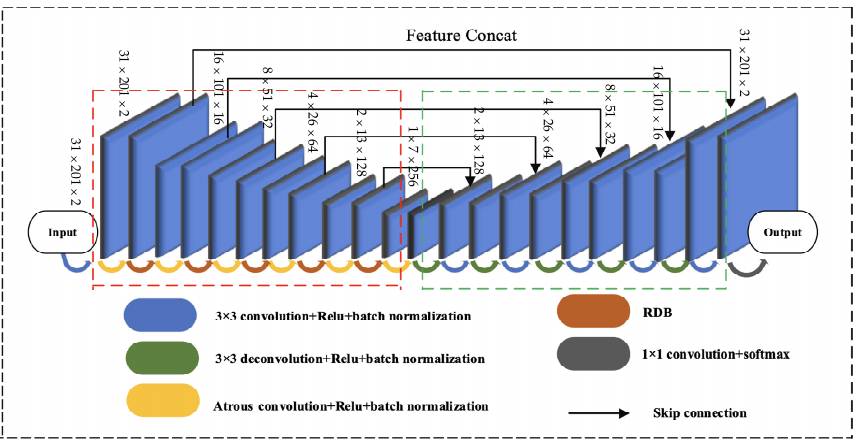
Figure 1. ARDU model structure